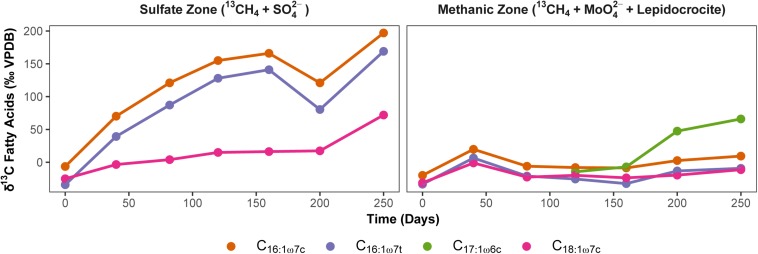
Uptake of 13CH4 label into bacterial polar lipid fatty acids during AOM. Development of carbon isotopic composition of dominant bacterial fatty acids (‰ VPDB) over time during S-AOM in the sulfate zone (supplemented with sulfate) and Fe-AOM in the methanic zone (supplemented with molybdate and lepidocrocite) is presented. Complete list of δ13C values of fatty acids and total uptake by each fatty acid is given in Supplementary Tables S3, S4.